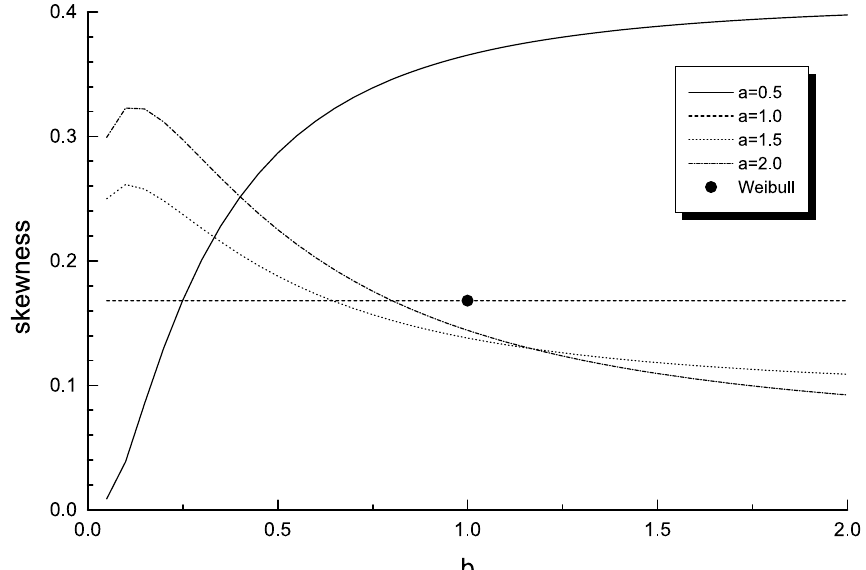
Fig. 5 – Skewness of the BW distribution as a function of parameter b for selected values of parameter a .